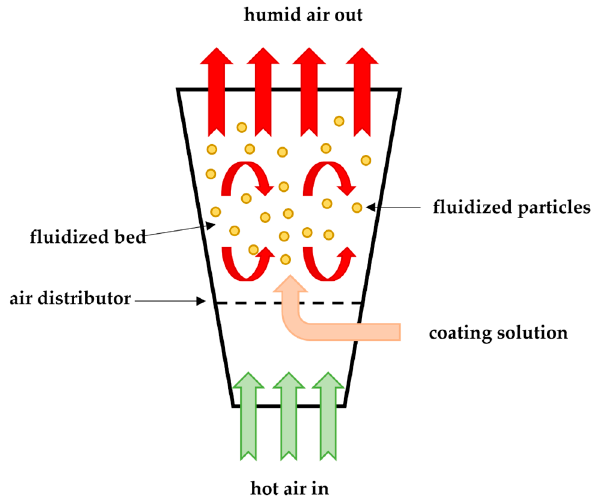
Figure 16. Schematic representation of bottom spray fluidised bed coating process (adapted from [166]).